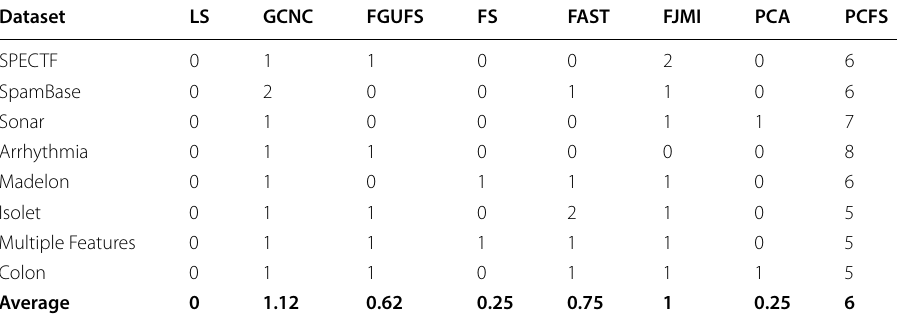
Multiple Features